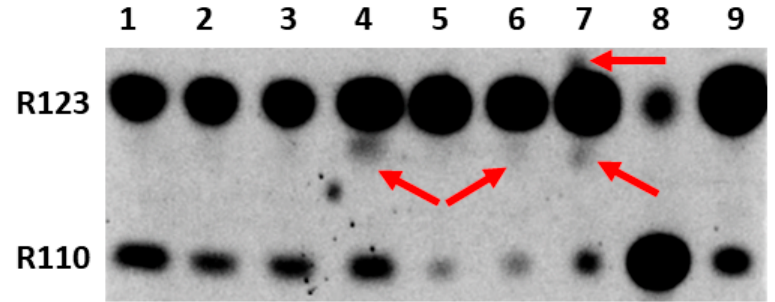
Figure 3. Thin-layer chromatogram of butanol extracts from rhodamine 123-treated astrocytes and glioma cells and their mitochondria. 1st lane, mitochondria isolated from astrocytes incubated for 2 h with Rh123 (2 µ M); 2, mitochondria isolated from intact astrocytes with subsequent 2-h incubation with Rh123 (2 µ M); 3, cytoplasmic fraction of astrocytes incubated for 2 h with Rh123; 4, cytoplasmic fraction of glioma cells incubated for 2 h with Rh123 (2 µ M), 5, membrane fraction of glioma cells incubated for 2 h with Rh123; 6, mitochondria isolated from glioma cells incubated for 2 h with Rh123 (2 µ M); 7, mitochondria isolated from intact glioma cells followed by incubation for 2 h with Rh123 (2 µ M); 8, commercial sample of Rh110; 9, commercial sample of Rh 123. Densitometric analysis gave a ratio of Rh123:Rh110 as 51, 47, 35, 33, 15, 18, 15, 24, and 20 for lanes 1–9